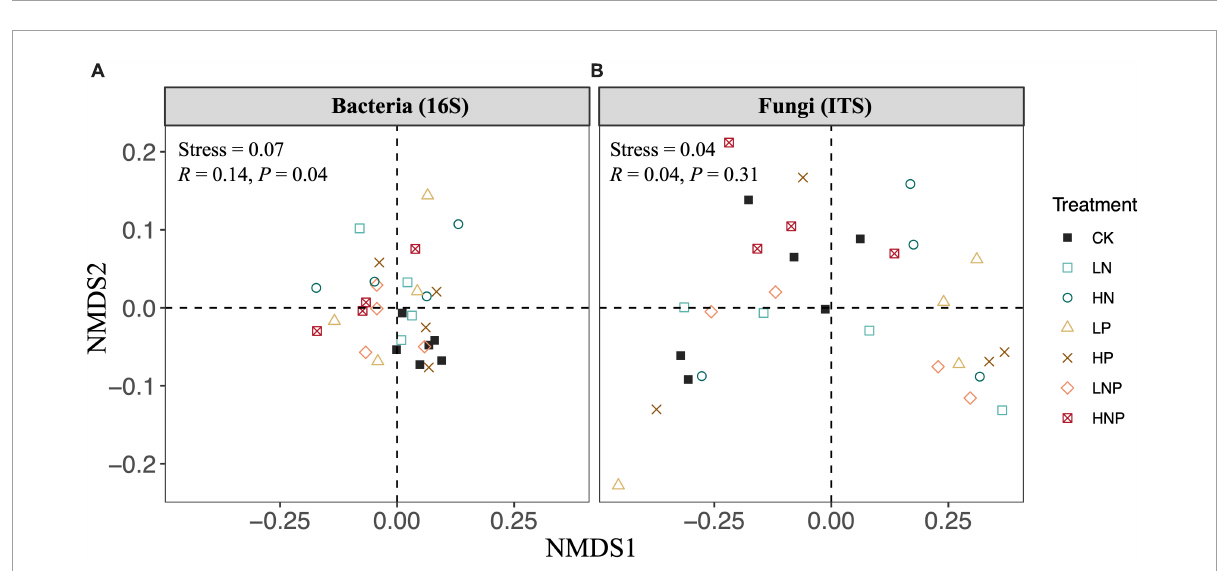
FIGURE4 Non-metric multi-dimensional scaling plots (NMDS) for visualizing the differences in soil bacterial (A) and fungal (B) community compositions across different nutrient additions. The results of analysis of similarity were shown as text in panels. LN, low N; HN, high N; LP, low phosphorous; HP, high phosphorous; LNP, low N and low P; HNP, high N and high P; CK, control.